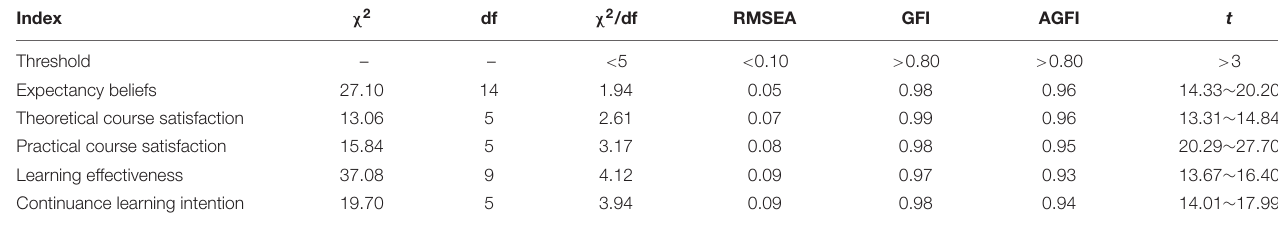
TABLE 2 | First-tier confirmatory